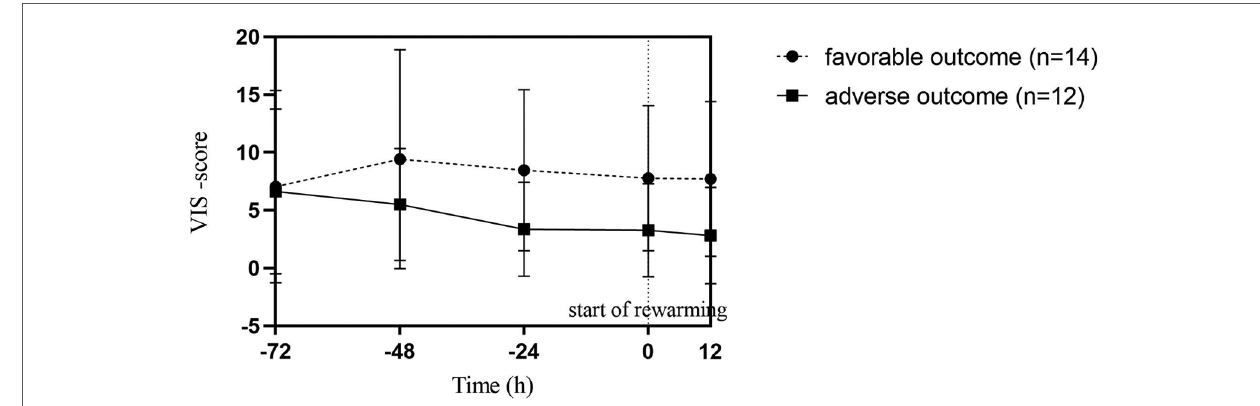
FIGURE 2 Vasoactive-inotropic (VIS) scores during therapeutic hypothermia in favorable and adverse neurodevelopmental outcome groups. Point 0 of the X axis marks the start of rewarming. Datapoints represent the median of individual patient scores with interquartile ranges. Each patient score was calculated by averaging hourly scores of the previous period. There was no statistical difference between the two outcome groups.